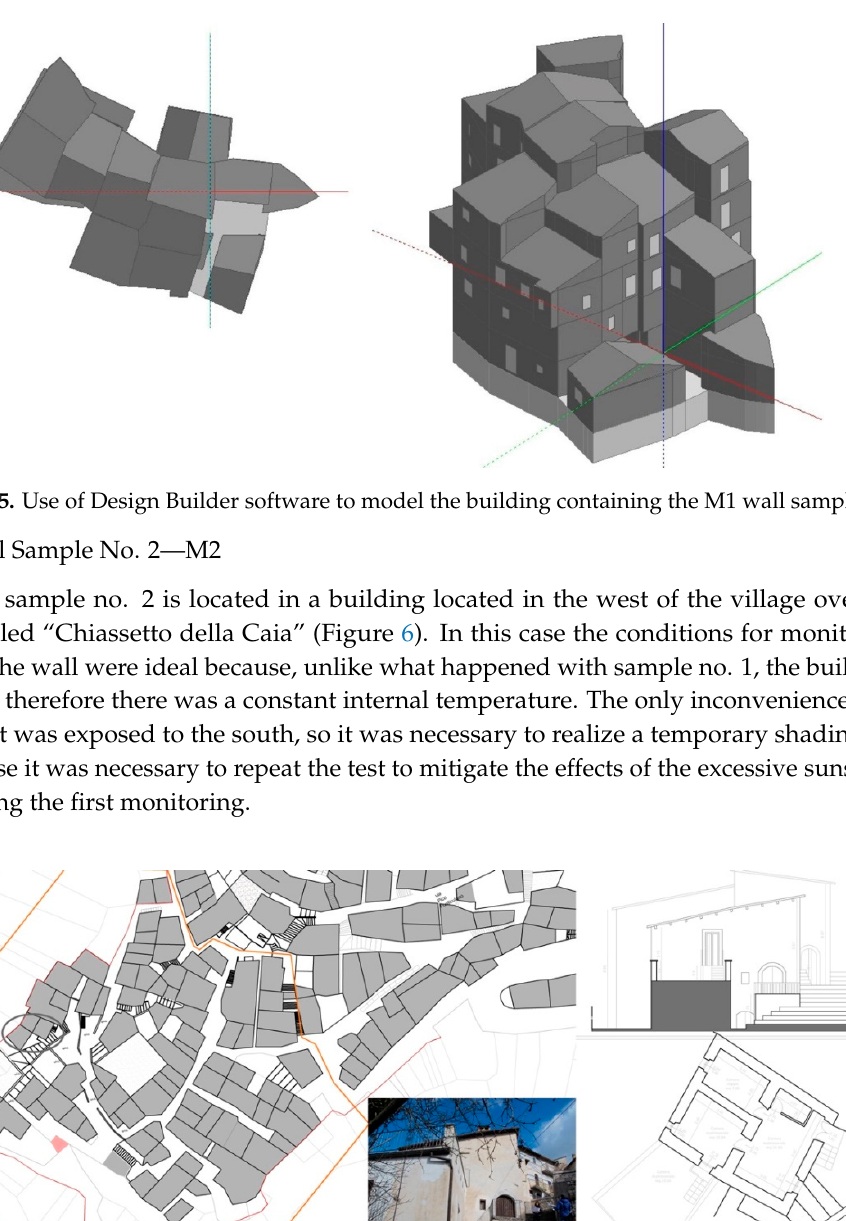
Figure 5. Use of Design Builder software to model the building containing the M1 wall sample.